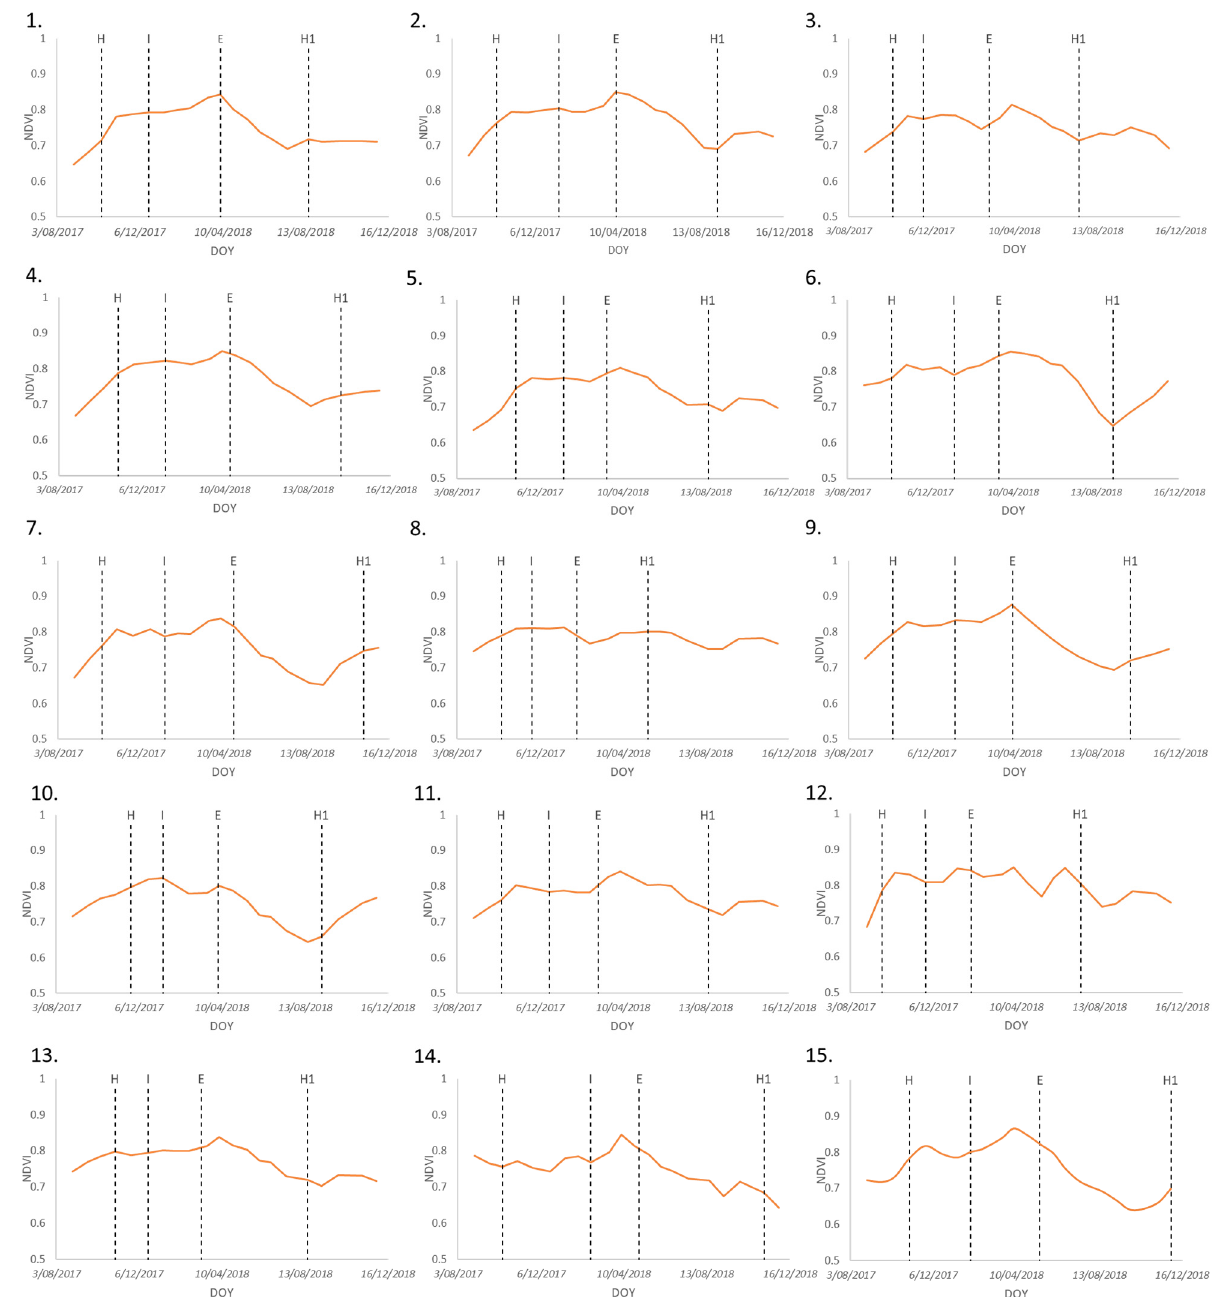
Figure 7. Time series of NDVI averages of banana plant crowns (solid line) from 21 UAV data collections. Subfigure number indicates plant location (1–15). Vertical markers indicate the timing of the first harvest (H), flower initiation (I), flower emergence (E), and subsequent harvest (H1). A wet soil background can also cause changes in VI values [69]. All plants suffered shredded leaves, particularly as a result of storms, with the study plants located at higher elevations in the southwestern portion of the study site (Plants 1–5) having greater exposure to wind and storm